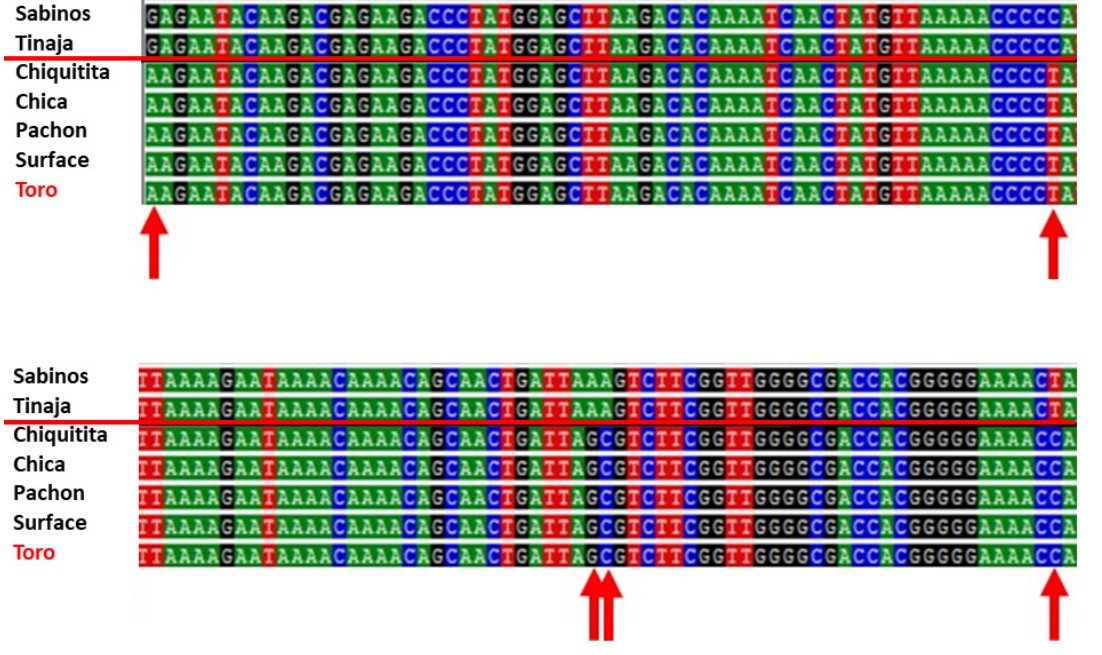
Figure 10. Fragment of the Astyanax mitochondrial 16S rRNA. Individuals from Toro system have identical sequence to populations harboring haplotype A (Cueva Chiquitita, Cueva Chica, Pachón caves, and Río Comandante surface river). Populations harboring haplotype B (Sabinos and Tinaja caves) have five bp disagreements in this fragment, indicated by red arrows.